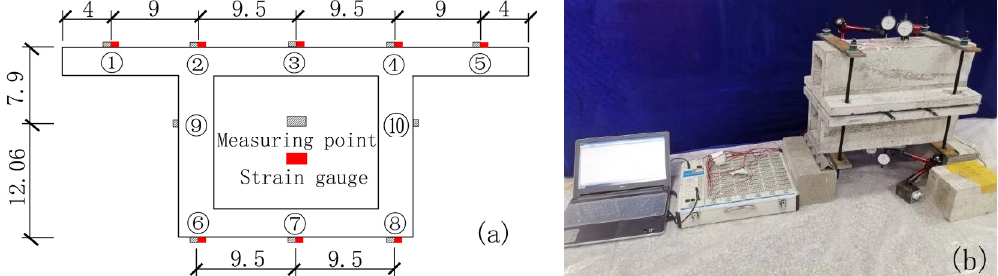
Figure 2. Model box girder measuring points and strain gauge arrangement (unit: cm). ( a ) Arrangement of measuring points and strain gauges; ( b ) Loading method.